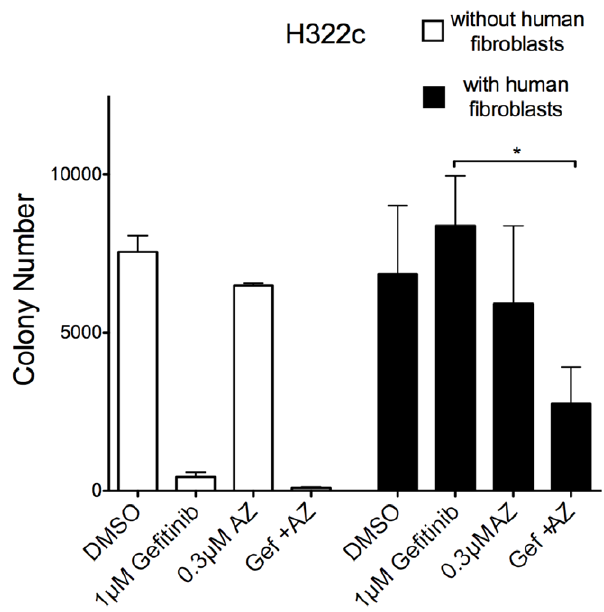
Figure 5. Co-culture with human fibroblasts prevents EGFR TKI dependent growth inhibition. A. H322c cells were analyzed for anchorage-independent growth in the presence or absence of HGF-1 fibroblasts as described in the Materials and Methods. The data are the mean and SEM of 3 independent experiments. Statistical analysis by 2way ANOVA revealed significant increases in growth where * indicates p , 0.05.